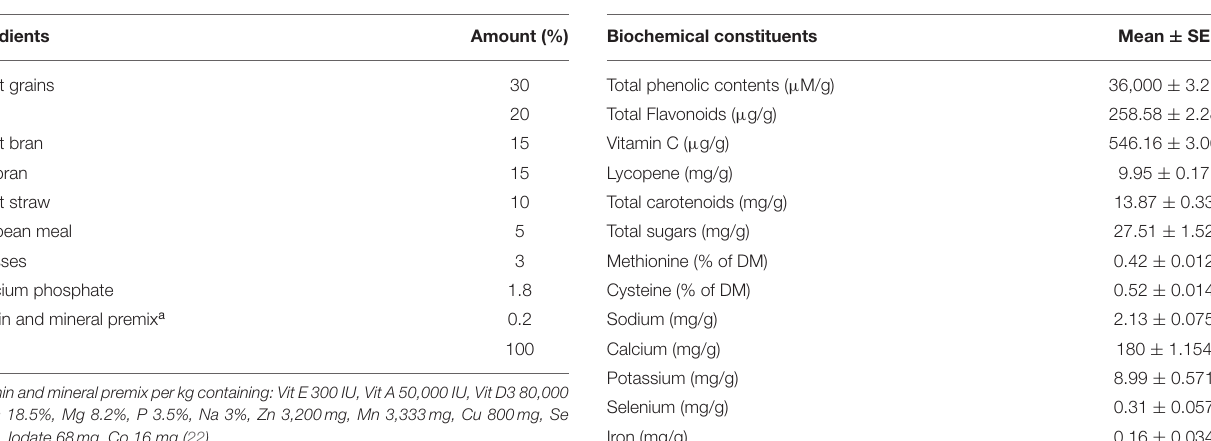
TABLE 3 | Nutritional constituent analysis of